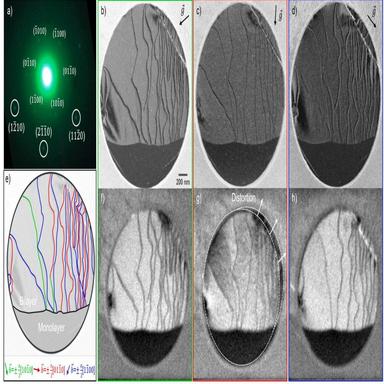
Comparison between aperture-based dark-field imaging and 4D-STEM analysis. a) Integrated diffraction pattern of the investigated sample area. b-d) Aperture based dark-field STEM images acquired with the three reflections marked with white circles in a). f-h) Virtual dark-field images reconstructed from 4D-STEM data using the same reflections. e) RGB color representation of the dislocations and their Burgers vectors.